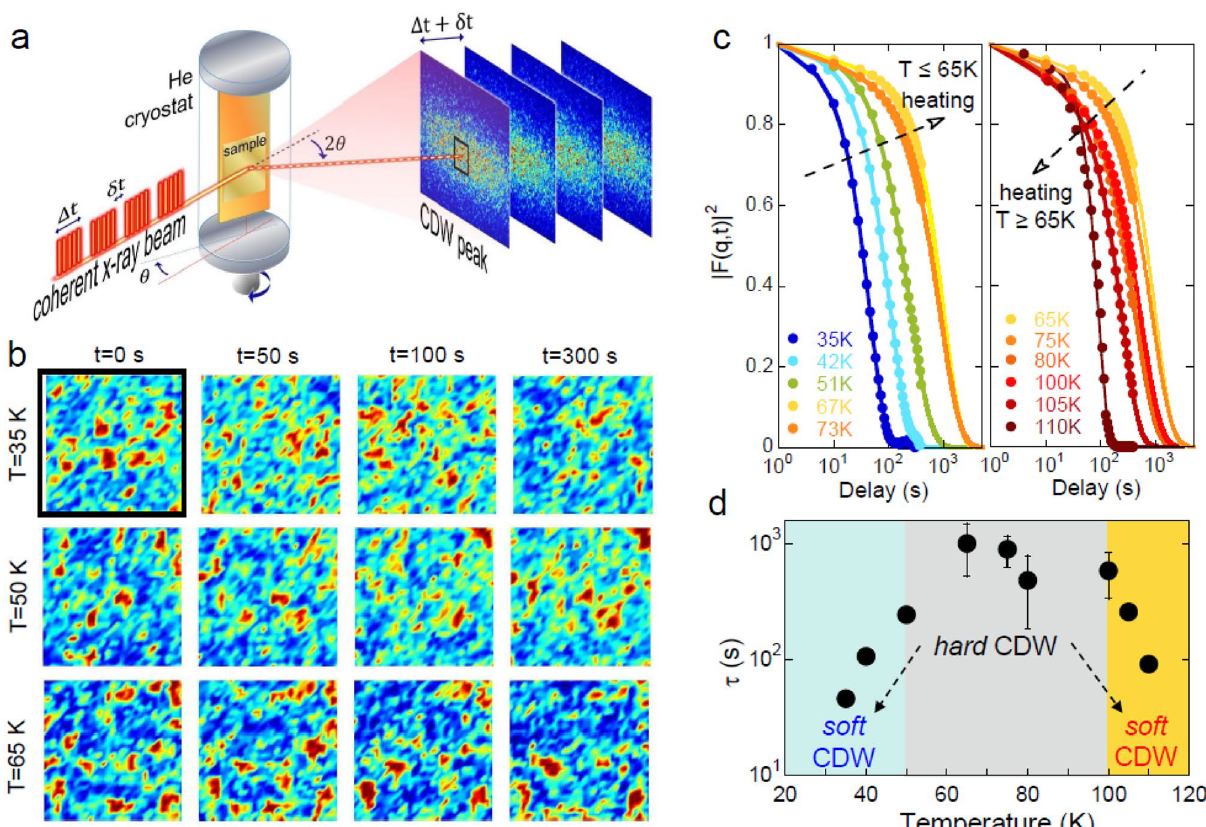
Figure 1. Temperature dependence of CDW dynamics measured by resonant soft X-ray Photon Correlation Spectroscopy in La 1.71 Sr 0.29 NiO 4 . ( a ) Experimental setup for the XPCS measurements. Coherent X rays hit the sample placed at the 2θ angle of the CDW peak. A time series of X-ray coherent diffraction images allows to study the development of the speckle spatial correlations. The region of interest, ROI, inside the square, where the intensity is more intense and stable has been used for analysis. ( b ) Images of speckle data recorded at T = 35 K, T = 50 K and T = 65 K in the selected ROI at different times. The larger the delay time, the more the speckle pattern differs from the initial one. ( c ) Autocorrelation function vs. delay measured at the indicated different temperatures. Experimental data are indicated by full circles along the solid lines fits obtained by using the stretched exponential model of Eq. (2). ( d ) Time delay, τ, extracted by fitting the |F(q,t)| 2 using Eq. (2). The time delay of fluctuations reaches values higher by a factor 100 passing from the hard region to the soft regions at both high and low dynamical critical exponent, which is typically around 2 and C is a constant. The term Cξ z times k B , the Boltz- mann constant, is an effective energy barrier height for activated fluctuations. We have developed our computer code for the ADS model introducing a constant correlation length, ξ 0 a , to take structural defects of the sample into account. The dashed line in Fig. 3a shows the fitting curve to the measured characteristic decay times τ obtained by the modified ADS model